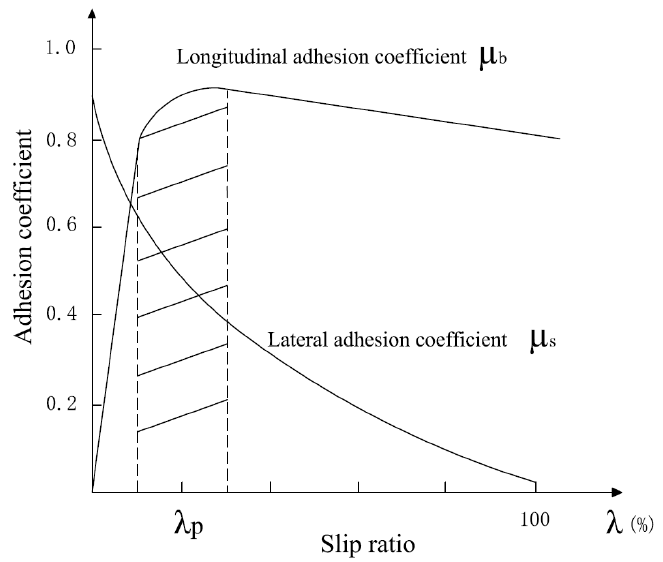
Figure 8. The relationship between road adhesion coefficient and wheel slip ratio